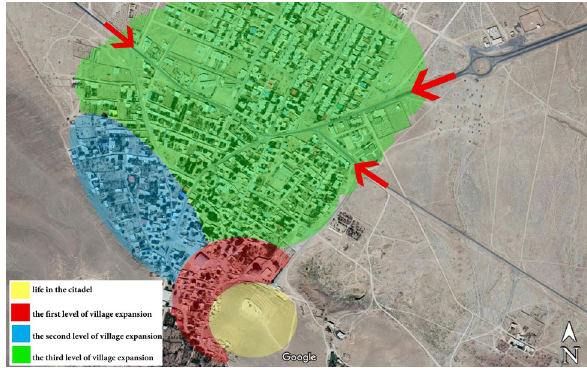
Figure 4. the village throughout the time,